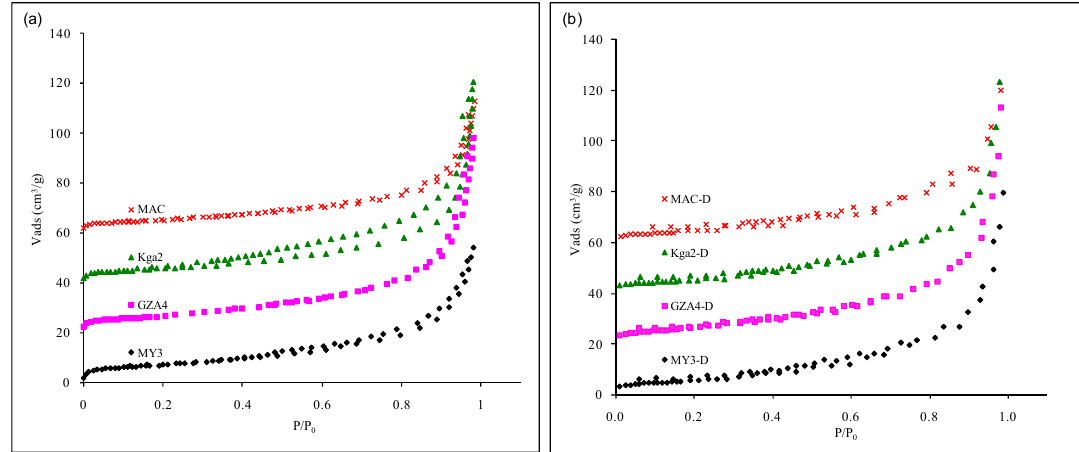
Figure 5. Nitrogen adsorption isotherm: ( a ) raw kaolinite; ( b ) DMSO-intercalated kaolinite. Note: The curves are offset for clarity. The shifting constant is 20 cm 3 /g.